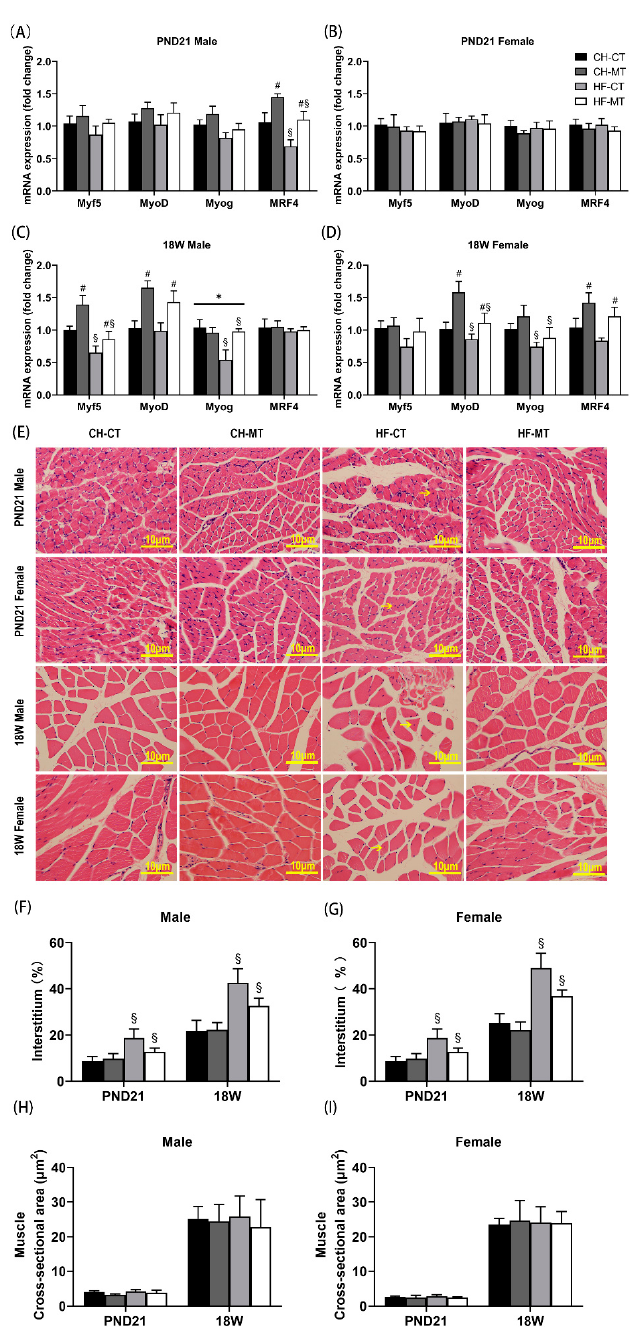
Figure 3. mRNA expression of myogenesis-related genes and representative histological sections of offspring skeletal muscle. mRNA expression of myogenesis-related genes was measured in skeletal muscle of PND21 males ( A ), PND21 females ( B ), 18W males ( C ) and 18W females ( D ). ( E ) H&E staining of representative histological sections of skeletal muscle. Scale bar = 10 µ m. Percentage of interstitium in muscle of male ( F ) and female ( G ) offspring, and muscle cross-sectional area of male ( H ) and female ( I ) offspring were analyzed. Data are expressed as mean ± S.E.M (n = 5–8 per group). Data were analyzed by two-way ANOVA, # main effect of maternal metformin, p < 0.05 versus control, § main effect of maternal HF diet, p < 0.05 versus maternal CHOW diet, * interaction effect of maternal HF diet and metformin, p < 0.05. Myf5, myogenic factor 5; MyoD, myogenic differentiation antigen; Myog, myogenin; MRF4, muscle regulatory factor